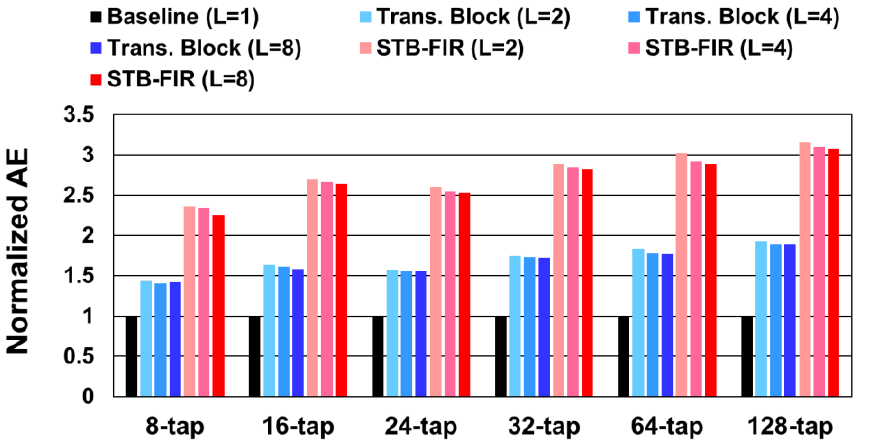
Figure 8. Normalized AE results of various reconfigurable FIR implementations.